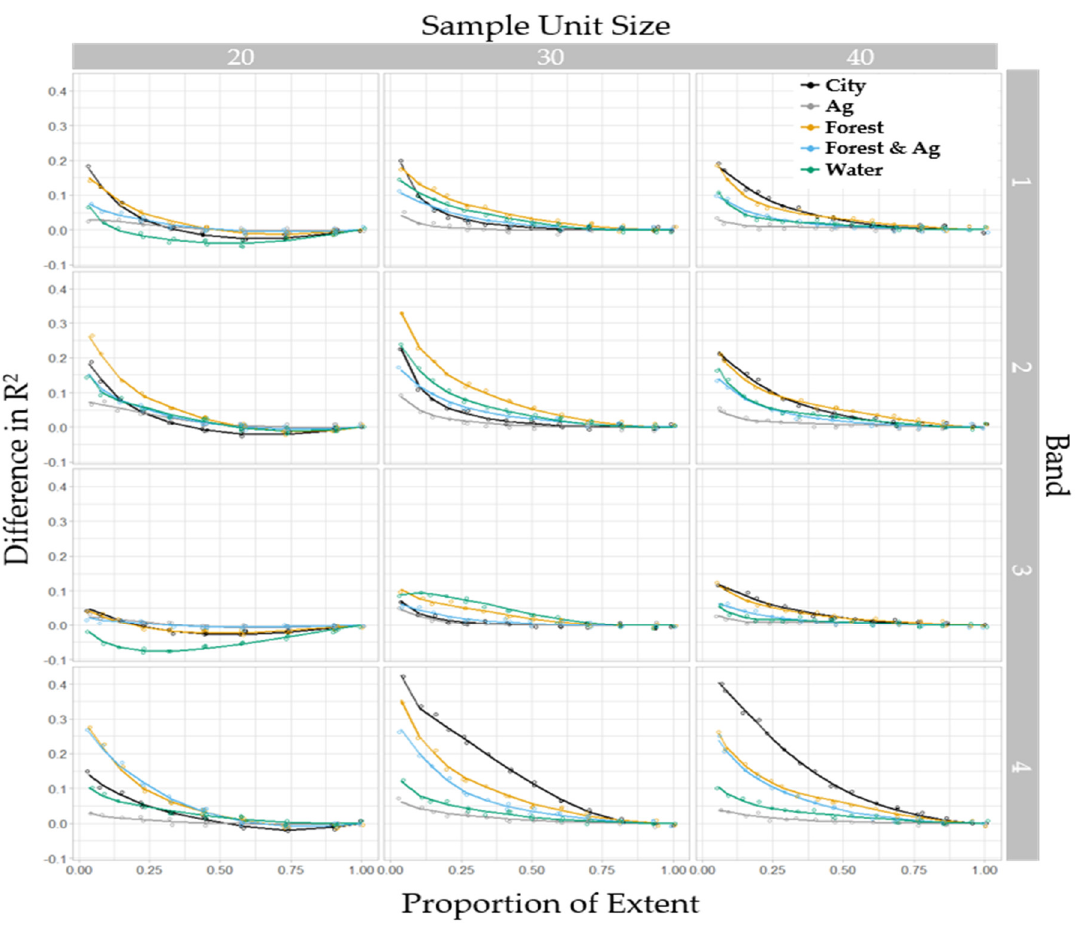
Figure A4. Reduction in the proportion of variation explained (R 2 ) for NAIP images by subsample intensity (Proportion of Extent), sample unit size and spectral band using SYS 4 and P all subsampling layout.